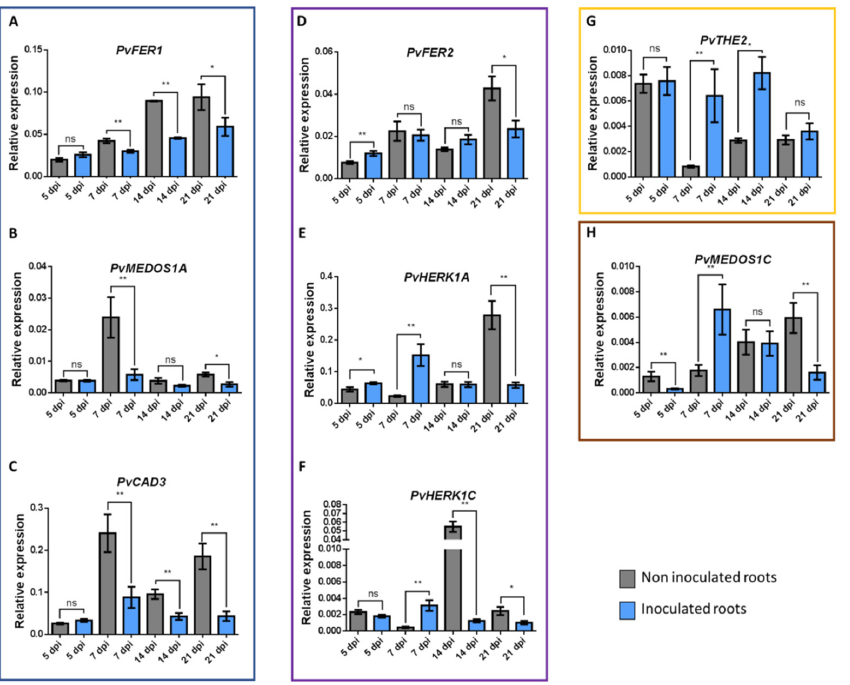
Figure 6. RT-qPCR expression analysis of eight P. vulgaris CrRLK1L genes. Relative expression profiles of eight CrRLK1L genes from P. vulgaris roots inoculated or not with R. tropici . Genes were classified into four groups according to their expression; the blue box indicates downregulated genes at the early and late time points: PvFER1 ( A ), PvMEDOS1A ( B ), and PvCAD3 ( C ); the purple box shows genes whose expression is upregulated at the early time points assessed, but downregulated later on: PvFER2 ( D ), PvHERK1A ( E ), and PvHERK1C ( F ); the yellow box indicates the expression of PvTHE2 ( G ), which was upregulated at the early and late time points; and the brown box displays PvMEDOS1C ( H ), showing variable expression at the different time points evaluated. The transcript accumulation of the selected genes was assessed by RT-qPCR and normalized according to elongation factor 1 α ( ef1 α ) gene expression. Blue bars represent inoculated roots, whereas gray bars indicate the expression levels in non-inoculated roots. The error bars represent standard deviation of the mean ( n = 6). A Student’s t -test was performed to evaluate significant differences, * represents p ≤ 0.05, ** represent p ≤ 0.01, ns represents non-significant difference.